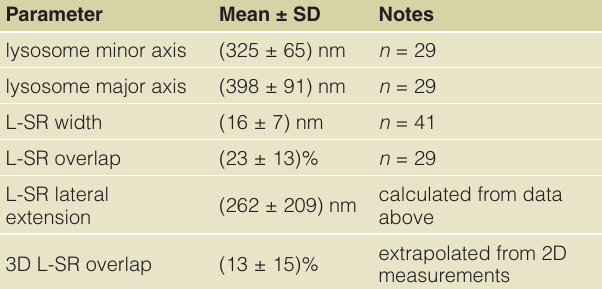
Table 1. L-SR junction characterization